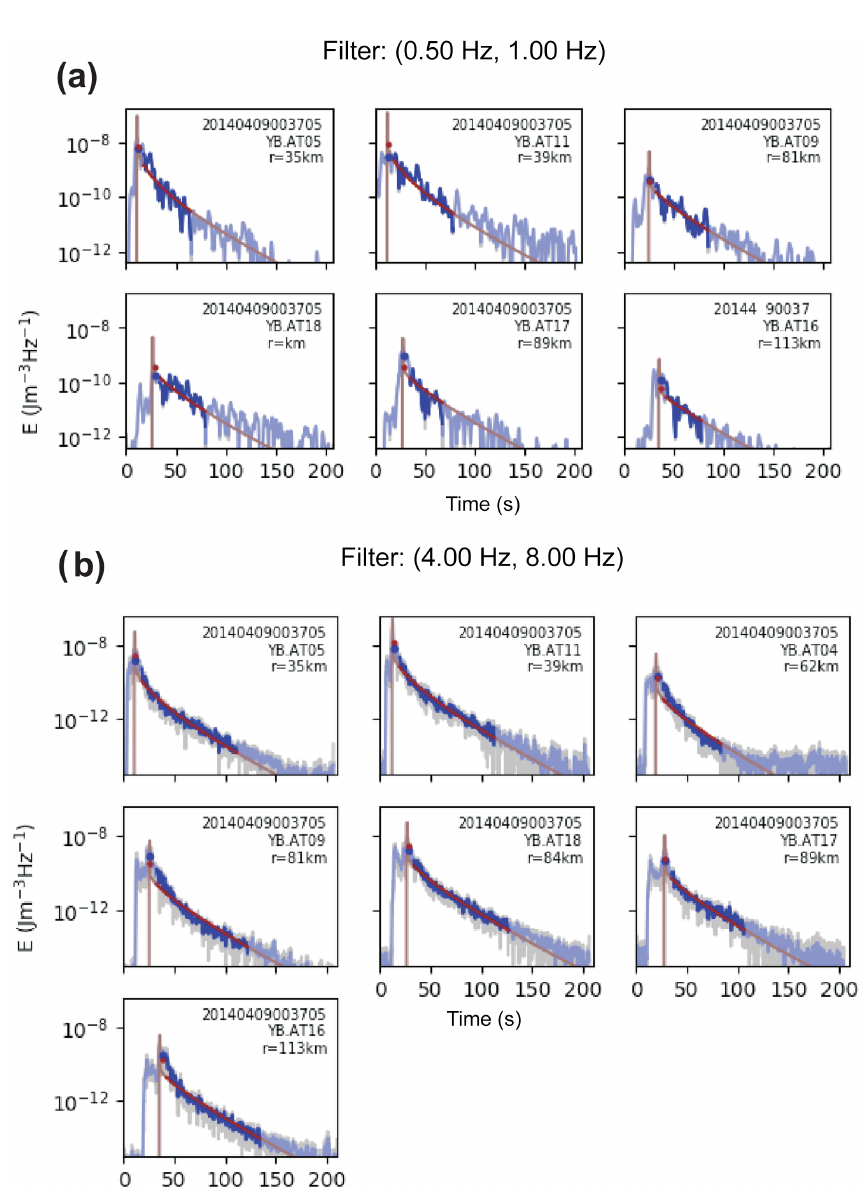
Figure 4. (a) Results of the inversion for the 9 April 2014 M w coda 3.2 earthquake: sample fits between observed and calculated energy densities in the frequency band 0.5–1.0Hz are given for six different stations (see the upper right corner for event ID, station name, and distance to hypocenter). Note that light blue curves represent the observed envelope. Smoothed observed and calculated envelopes in each panel are presented by blue and red curves, respectively. Blue and red dots show the location of the average value for observed and calculated envelopes within the S-wave window, respectively. (b) The same as in (a) obtained in the frequency band